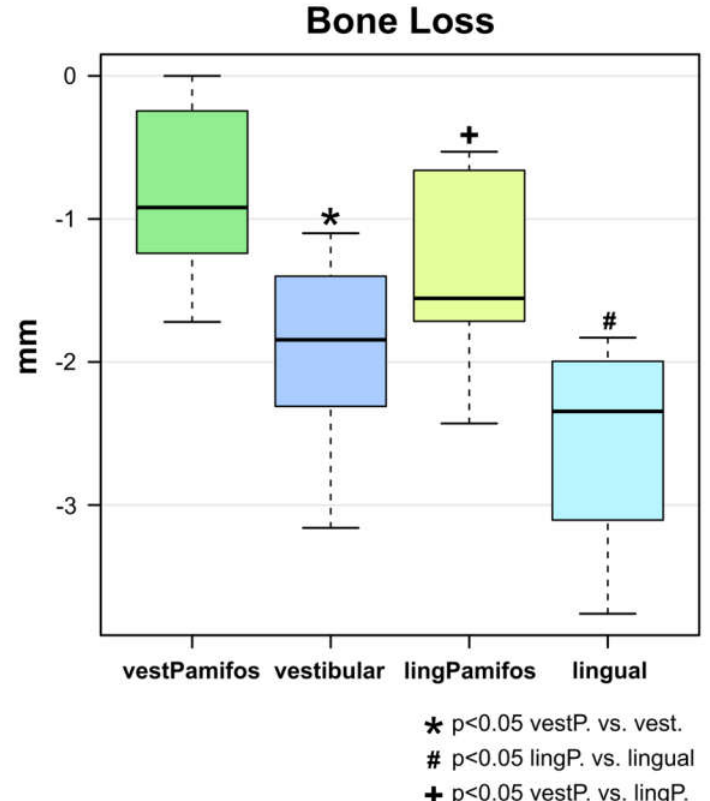
Figure 2. Boxplot analysis of the surface dimensional changes eight weeks after tooth extraction and OSS + pamidronate) compared with the control group (BEGO OSS) both buccal (  0.80 ± 0.57 mm vs.  1.92 ± 0.63 mm; p = 0.00298) and oral (  1.36 ± 0.58 mm vs.  2.56 ± 0.6 mm; p = 0.00104). The test